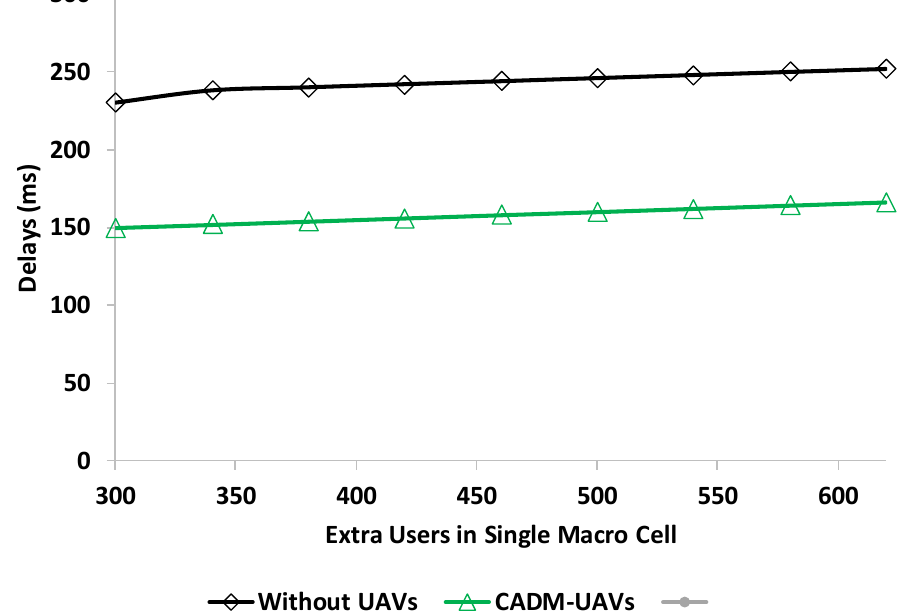
Figure 4. Delay analysis in the presence of user at cellular networks.